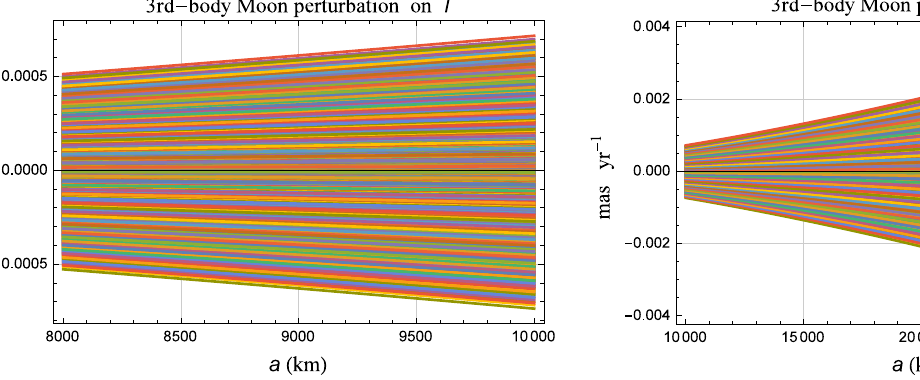
Fig. 4 Mismodeled rate of change of the satellite’s inclination, in mas year − 1 ,duetothethird-bodyMoonperturbationasafunctionofthe satellite’s semimajor axis a for e = 0 , I = 90 ◦ , (cid:2) = (cid:2) ⊕ + 90 ◦ . Each curve corresponds to a given pair of values of I (cid:2) , (cid:2) (cid:2) chosen within